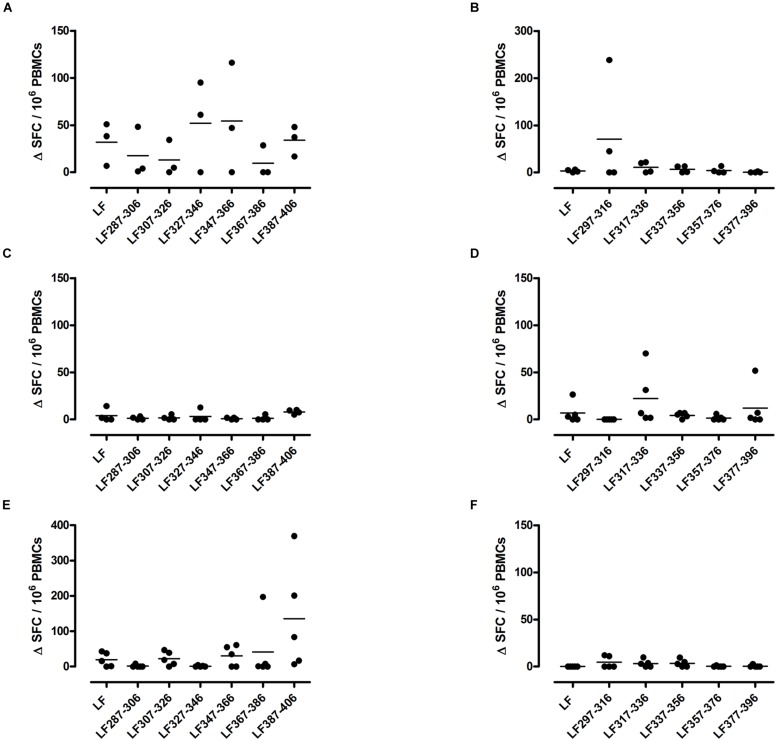
HLA transgenic mice immunized with LF peptide pools comprising domain III generate HLA-DR restricted CD4+ T cell cryptic epitopes. Transgenic mice; DR1 (A,B), DR15 (C,D), and DR4 (E,F) were immunized with pools designed to only include non-overlapping LF peptides comprising domain III. Draining lymph node cells were cultured in an IFNγ specific ELISpot plate with 25 μg/ml of the individual domain III LF peptides for 72 h. Results are given as the number of spots above background (ΔSFC)/106 PBMCs with mean ± SD (n = 3–5 mice for each column).